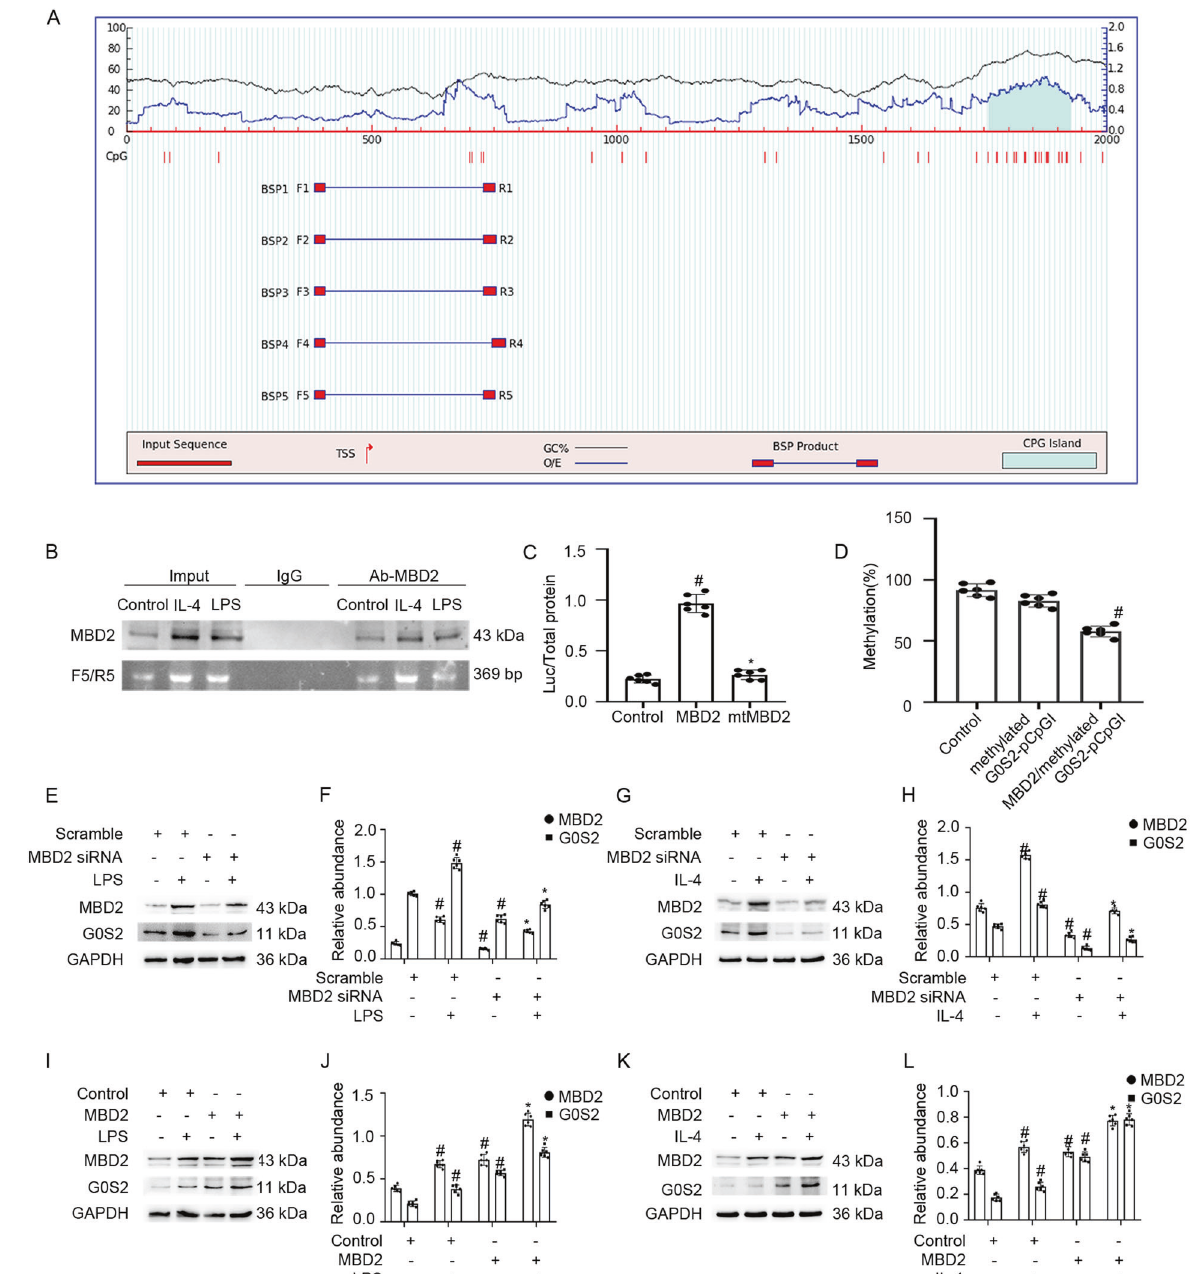
Fig. 4 MBD2 directly binds to CpG islands of promoter of G0S2 and positively activates transcription of them by hypomethylation of promoter. A The prediction patterns of CpG islands of G0S2 promoter and fi ve pairs of primer were shown using the software of MethPrimer 2.0. B ChIP assays represent the binding sites of MBD2 interaction with CpG islands of the promoter of G0S2 under LPS or IL-4 treatment conditions. C Relative luciferase activity of MBD2 or MBD2 mutation plasmids co-transfected with methylated G0S2 pCpGI plasmid in M0 macrophages. D CpG-DNA methylation level of the G0S2 promoter region. E , G , I , and K Representative immunoblots of MBD2 and G0S2. F , H , J , and L Densitometry analysis of proteins levels, and normalized to internal control of GAPDH. Data are expressed as means ± sd ( n = 6). # P < 0.05 versus Scramble or Control group. * P < 0.05 versus LPS or IL-4 group.